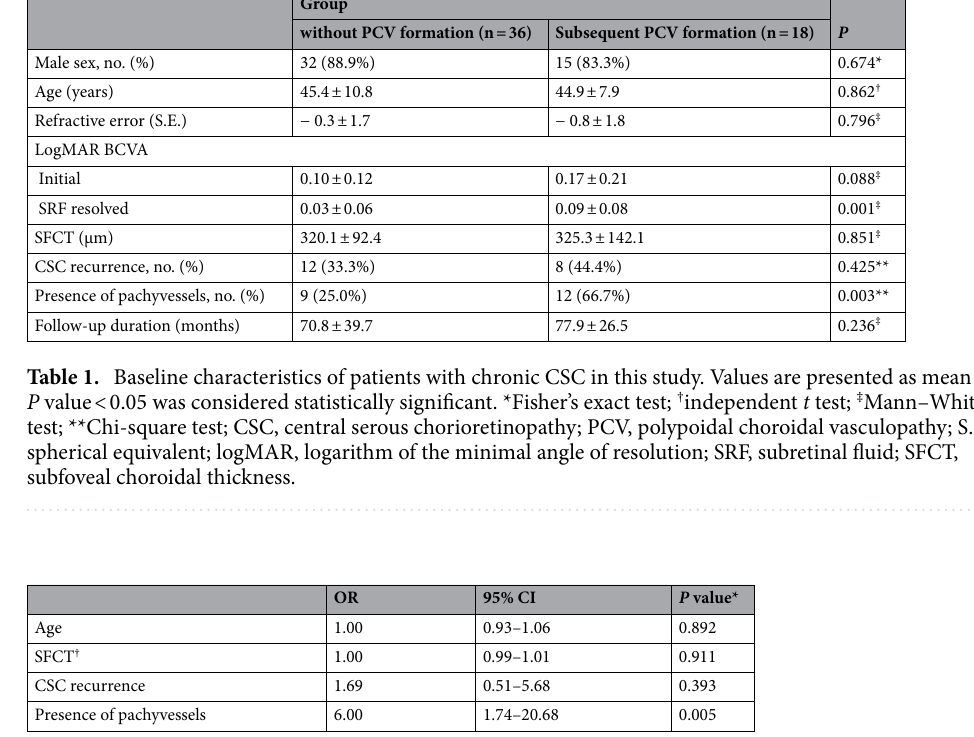
Table 2. The multivariate logistic regression for subsequent PCV Formation In Relation To Different Variables. * P value < 0.05 was considered statistically significant. † Subfoveal choroidal thickness of CSC at baseline. OR, odds ratio; CI, confidence interval; PCV, polypoidal choroidal vasculopathy; CSC, central serous chorioretinopathy.